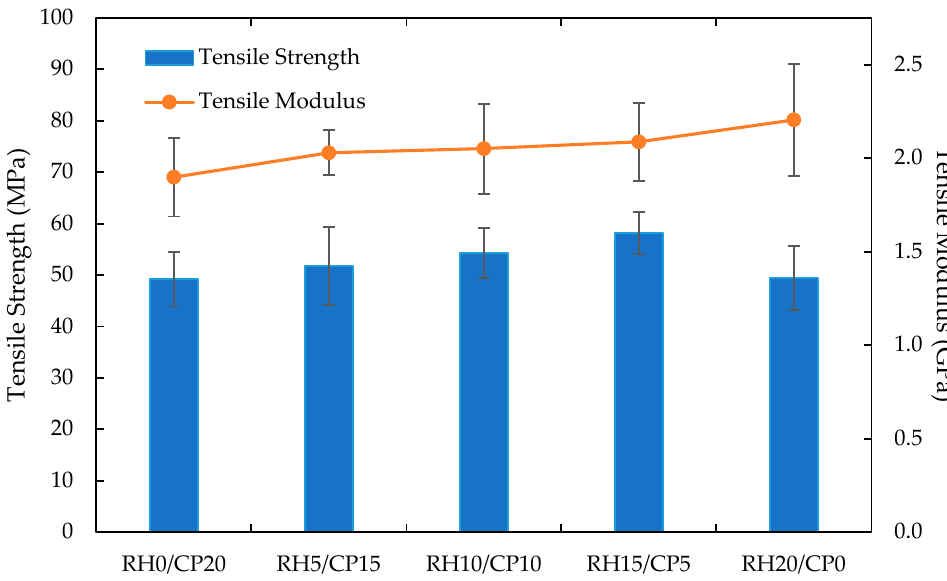
Figure 3. Tensile properties of RH/CP reinforced ABS blend composites.